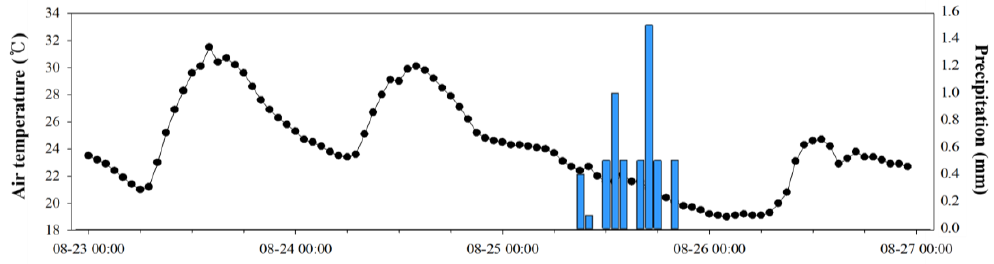
Figure 11. Time series of observed air temperature and precipitation at the Seoul weather station (SWS) during 23–26 August.